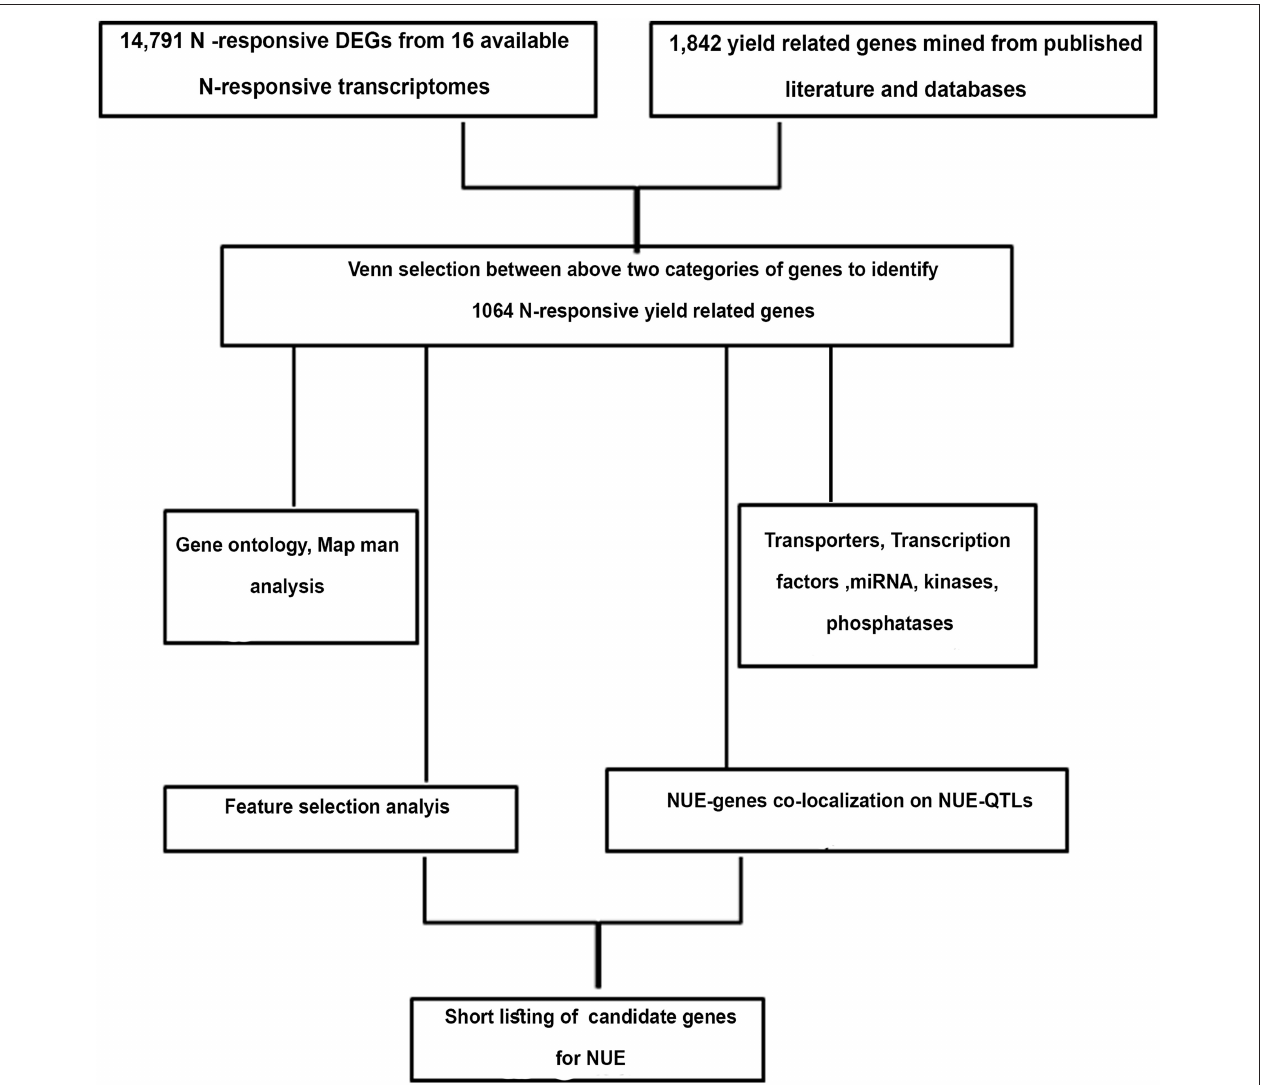
FIGURE 1 | Flowchart used for identification and shortlisting of candidate genes for nitrogen-use efficiency (NUE) in